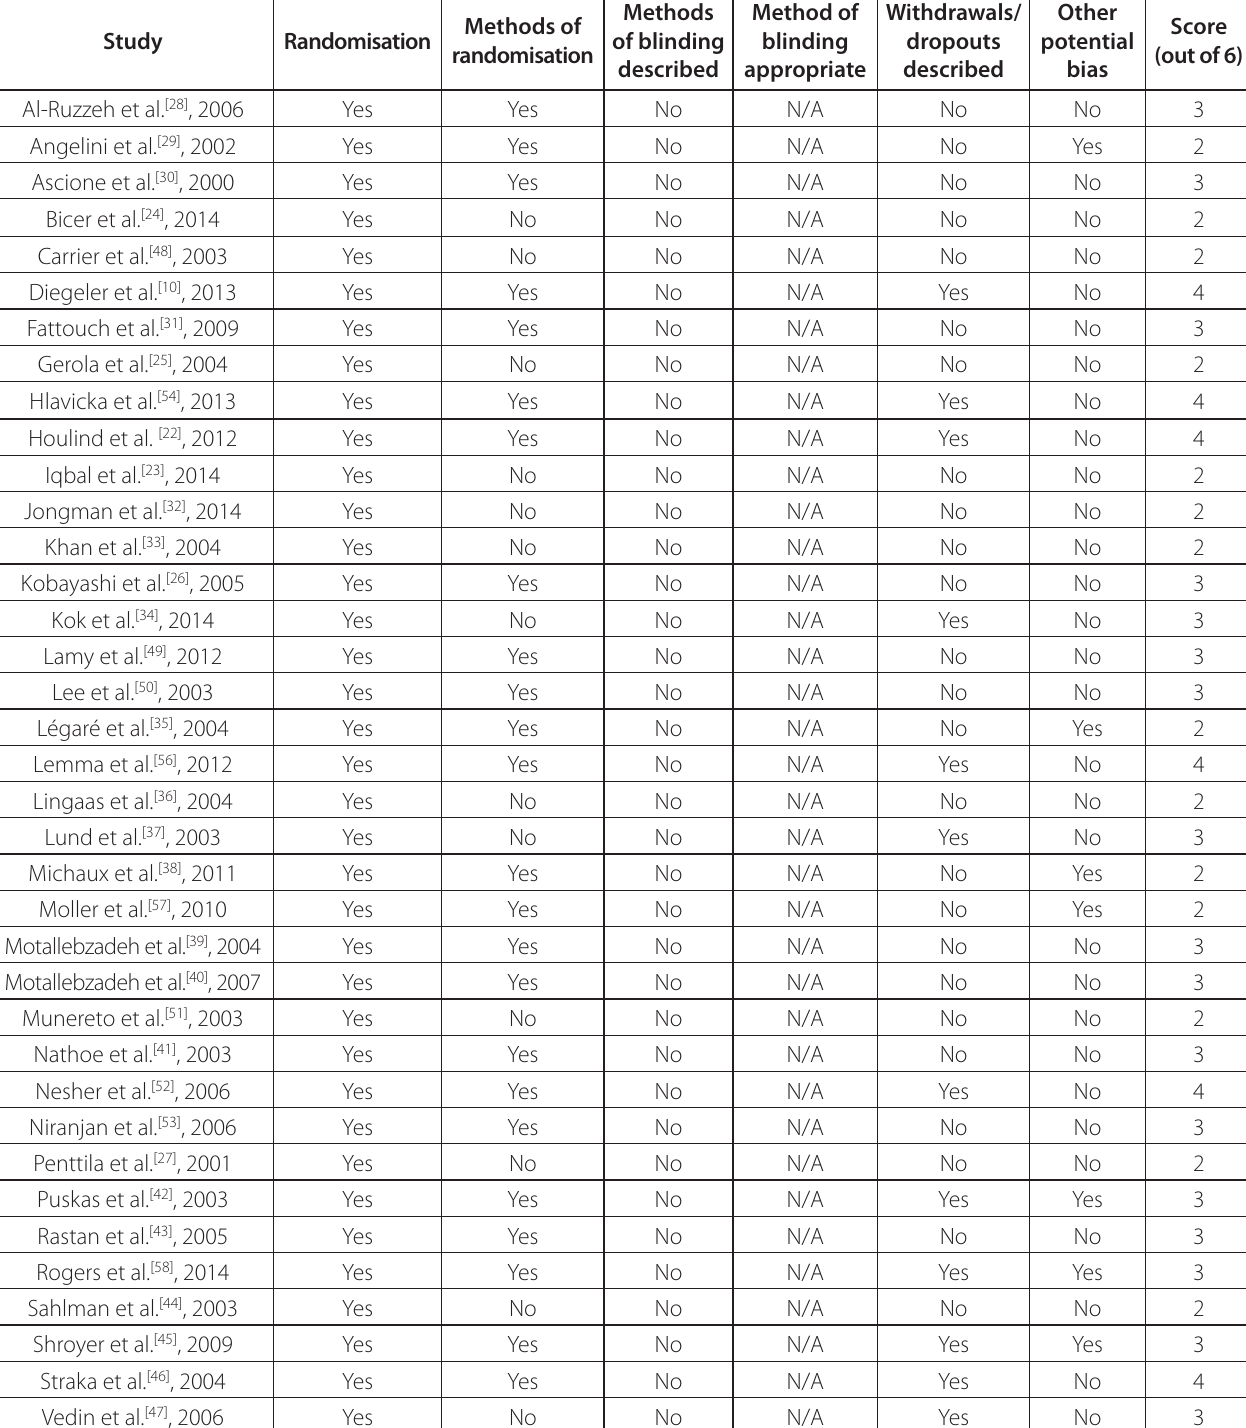
Supplementary Table 2 . Examination of study quality.